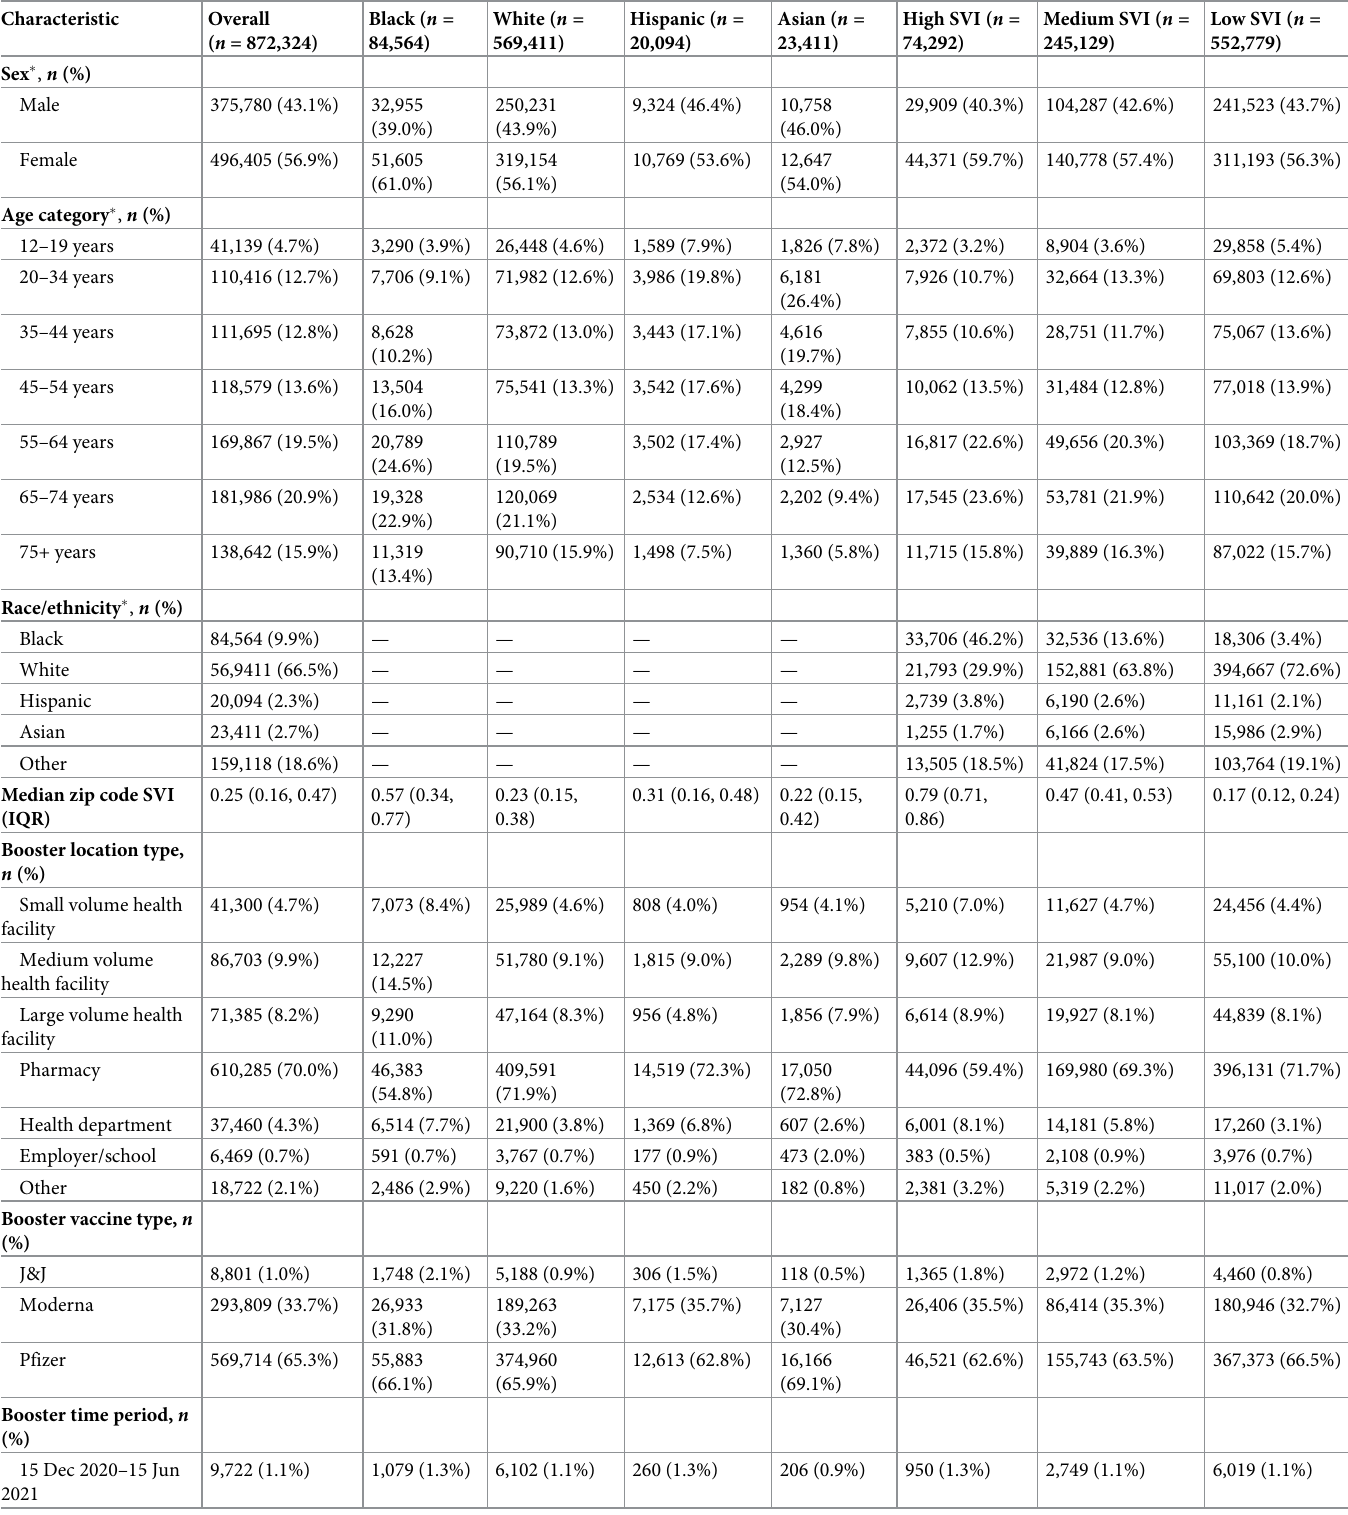
Table 2. Characteristics of individuals receiving a booster